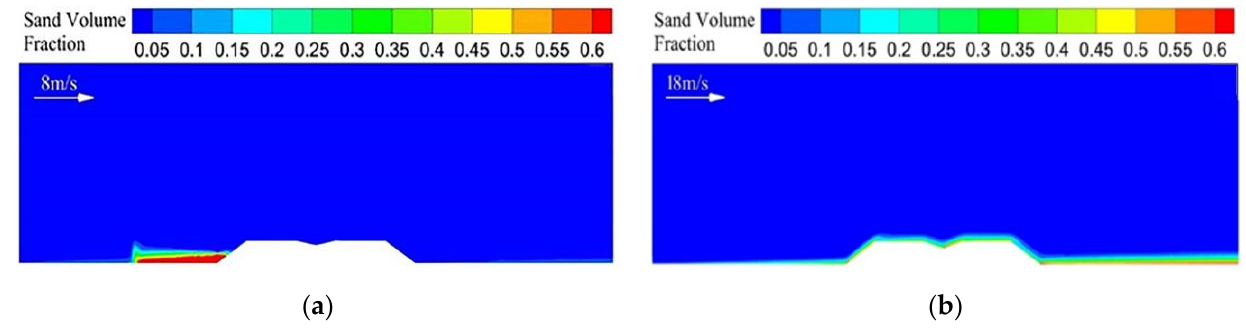
Figure 12. Distribution of sand volume fraction around embankment in flat terrain ( a ) Wind speed of 8 m/s; ( b ) Wind speed of 18 m/s.